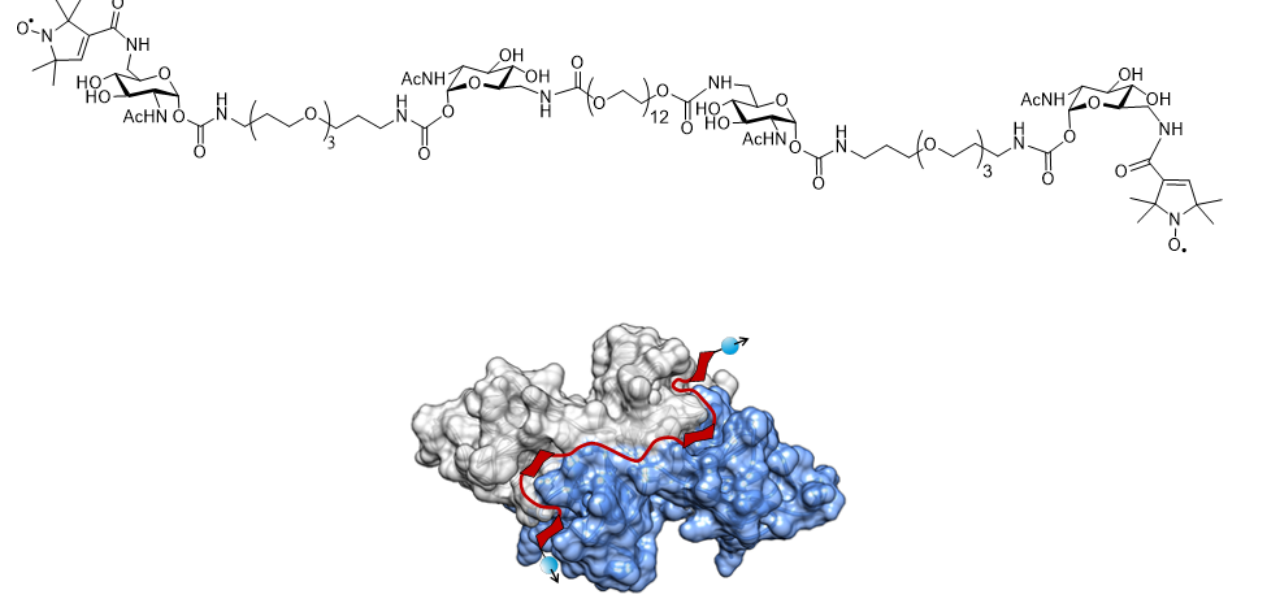
Figure 1. The structure of the tetravalent ligand with its two spin-(2,2,5,5-tetramethyl-3-pyrrolin-1-yloxycarbonyl) labels and the ligand bound to WGA. The visualisation of the dimeric WGA with the subunits coloured in grey and blue is based on the crystal structure (PDB entry 2X52; Schwefel et al., 2010). In red, a schematic representation of the ligand is overlaid to the crystal structure. The ligand is suggested to bind with its four GlcNAc moieties to the primary binding sites of WGA. Blue balls and arrows indicate nitroxide spin labels.